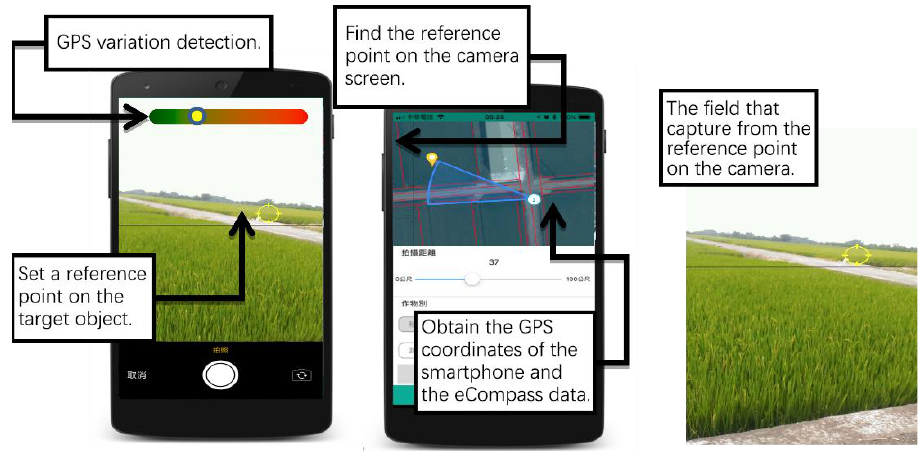
Figure 4. While taking photos, the proposed agricultural survey APP offers a reference point on the target object, and it has a GPS variation detection function.